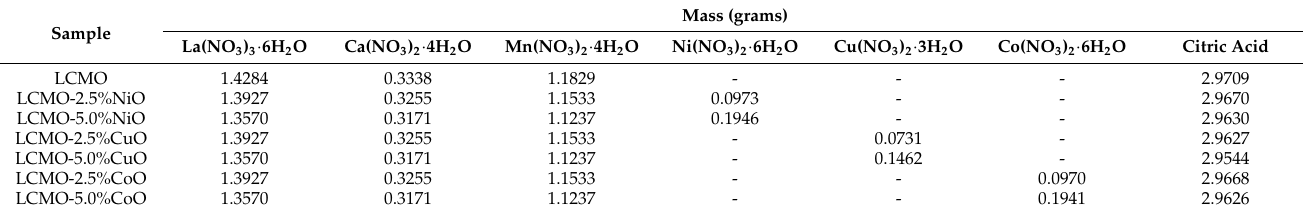
Table 1. Stoichiometry of chemicals used to synthesize LCMO–MO composites.